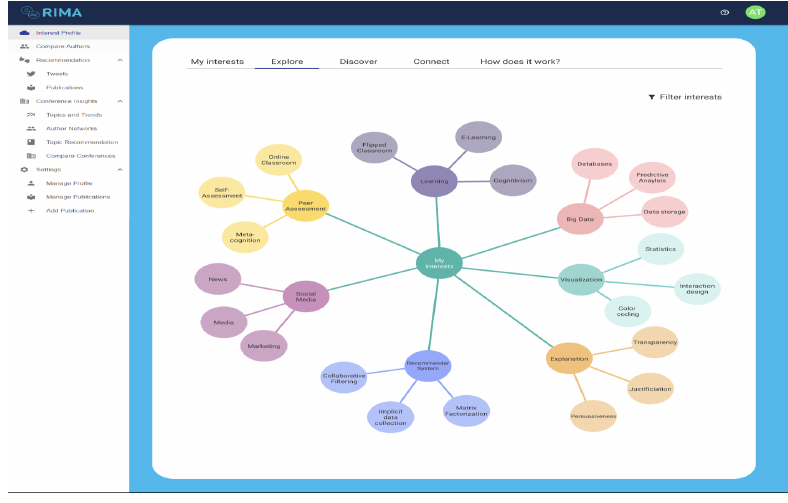
Figure 19. Explore interests.